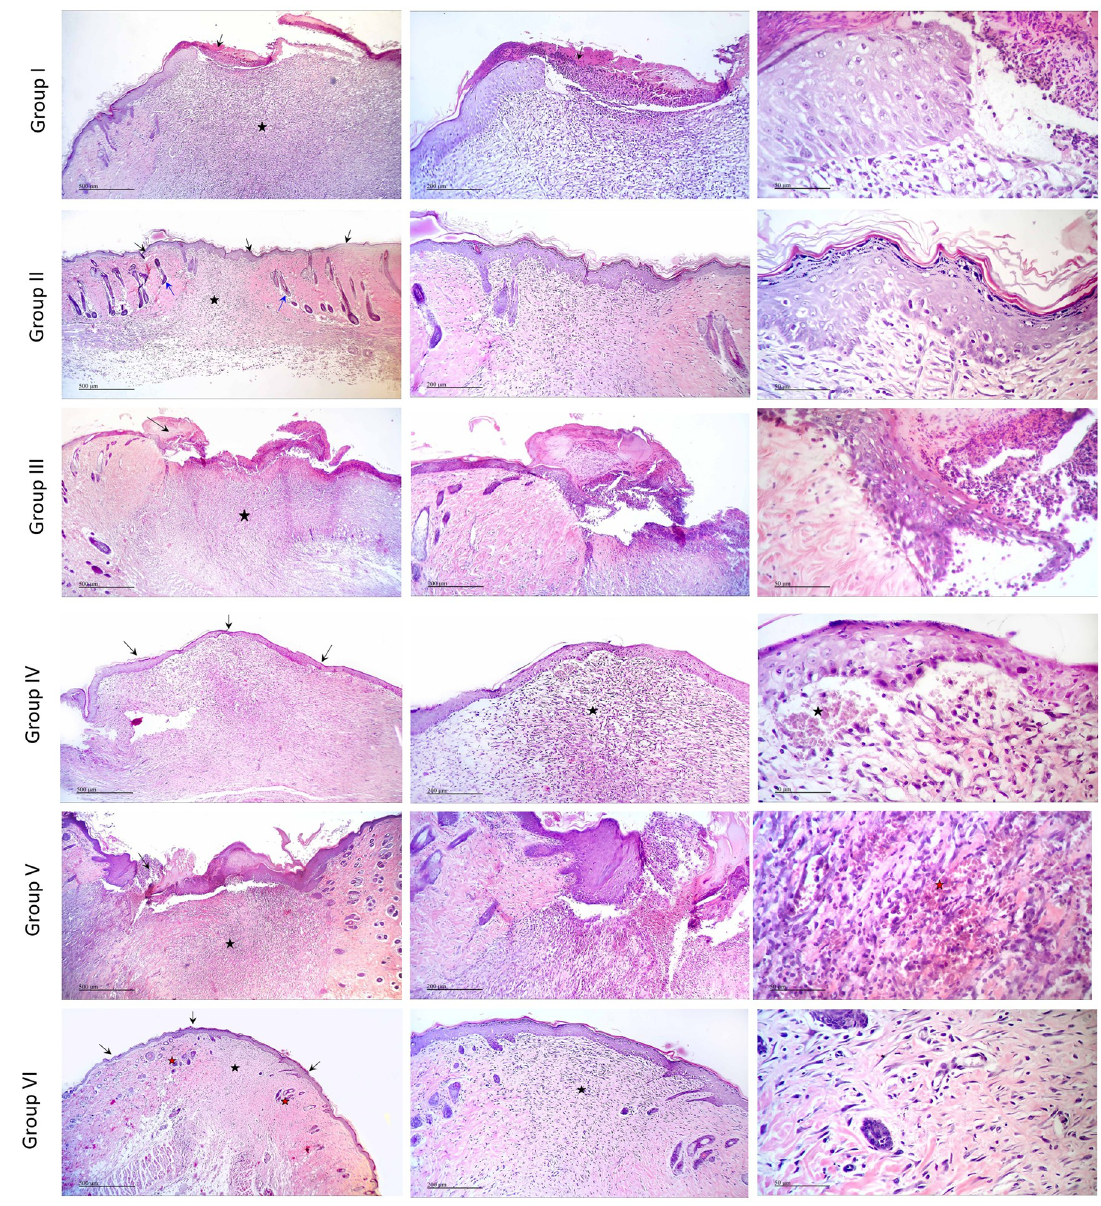
Fig 5. Histopathological view of wound healing and epidermal/dermal re-modeling in the groups administered different treatments on day 14 at magnification 4x, 10x and 40x.